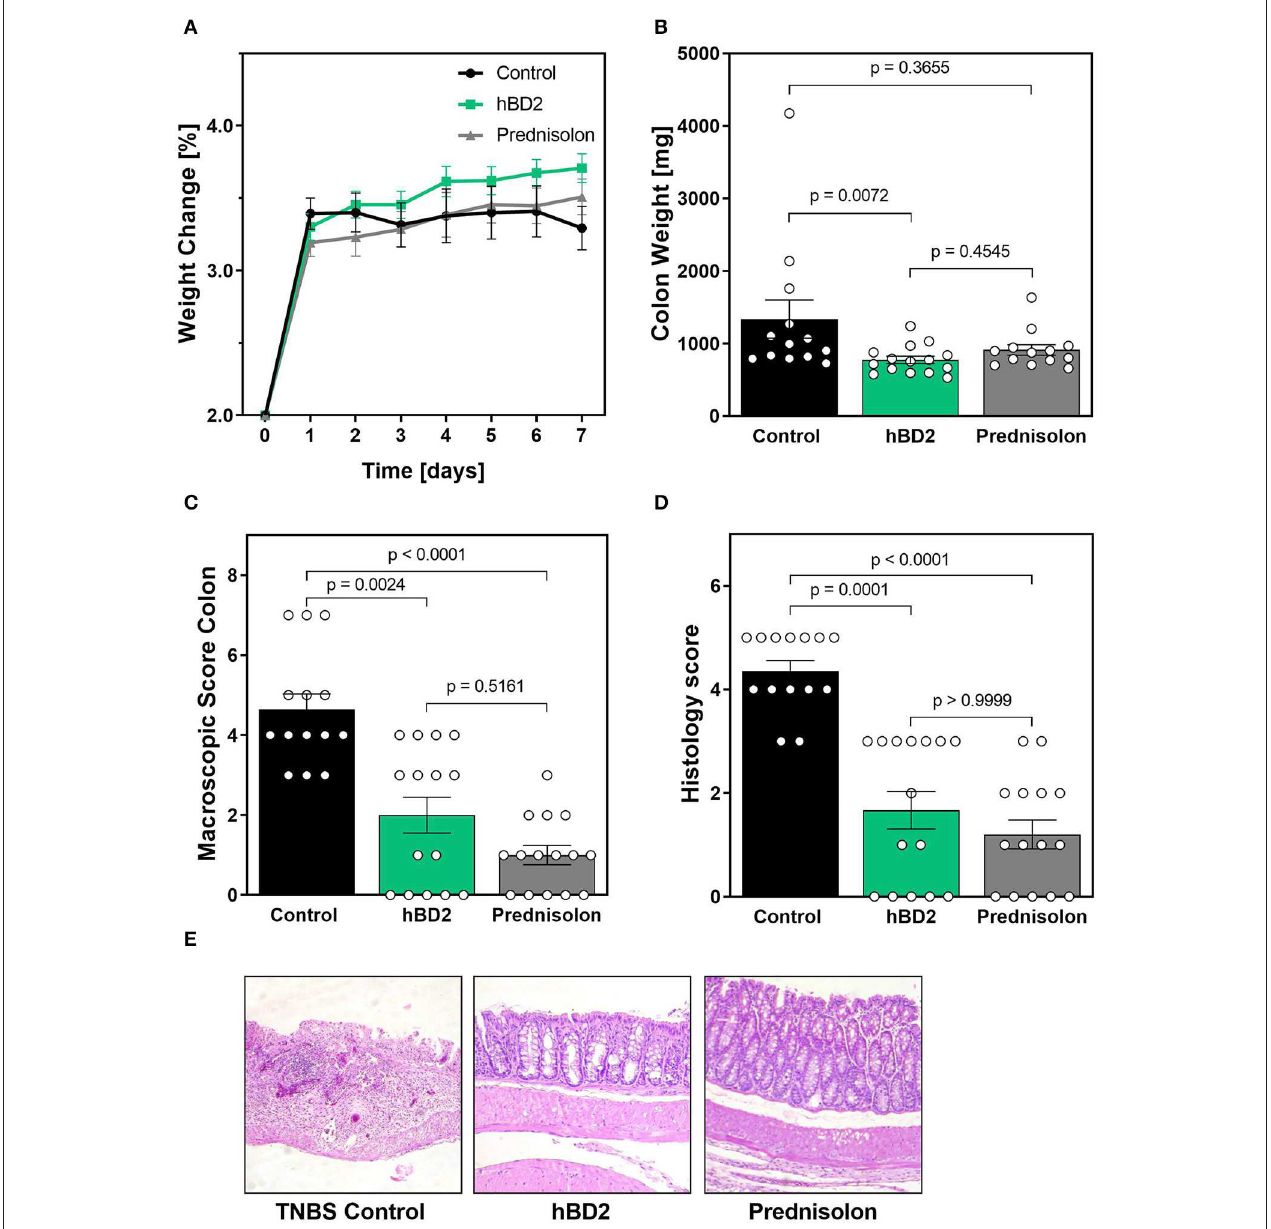
FIGURE 6 | hBD2 significantly improved TNBS colitis in vivo . Colitis was induced by a single dose of TNBS into the colon. Mice were then treated s.c. with different doses of hBD2 (0.1 mg/kg) or Prednisolone (10 mg/kg) once a day and monitored for 7 days. (A) Development of mouse weight during the experiment. After euthanization, the colon of the mice was examined for (B) colon weight, (C) macroscopic abnormalities, and (D) microscopic evidence of inflammation. (E) Representative images from the colon of differentially treated mice are shown. Results are presented as mean ± SEM, control group n = 14, prednisolone group n = 14, and hBD2 group n = 15. Appropriate statistical comparisons are shown within the graph by a Kruskal-Wallis-test for non-parametric data with a Dunn’s post-test.